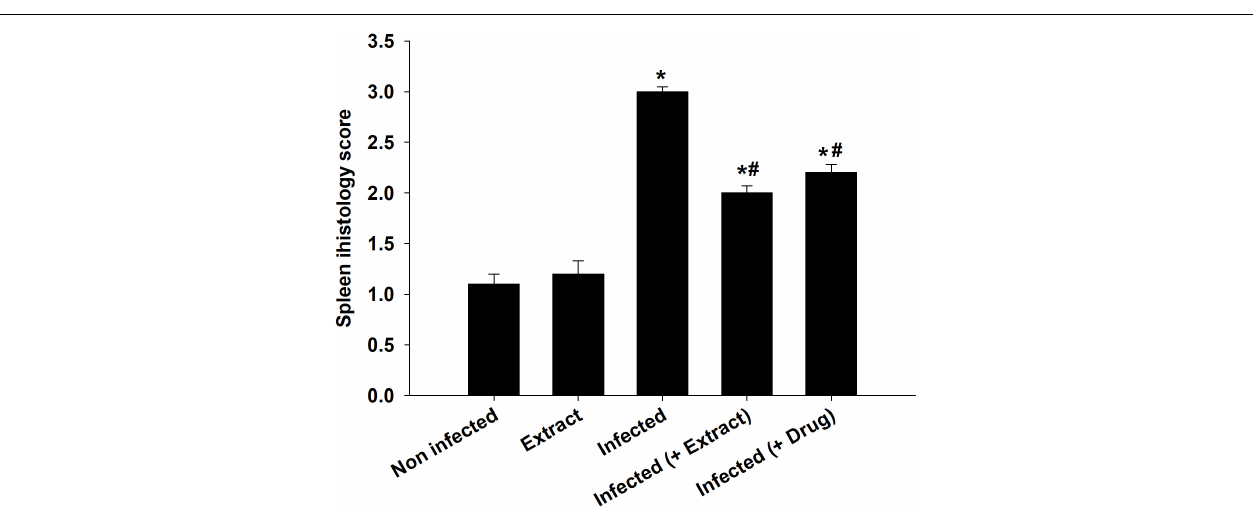
Frontiers in Microbiology |